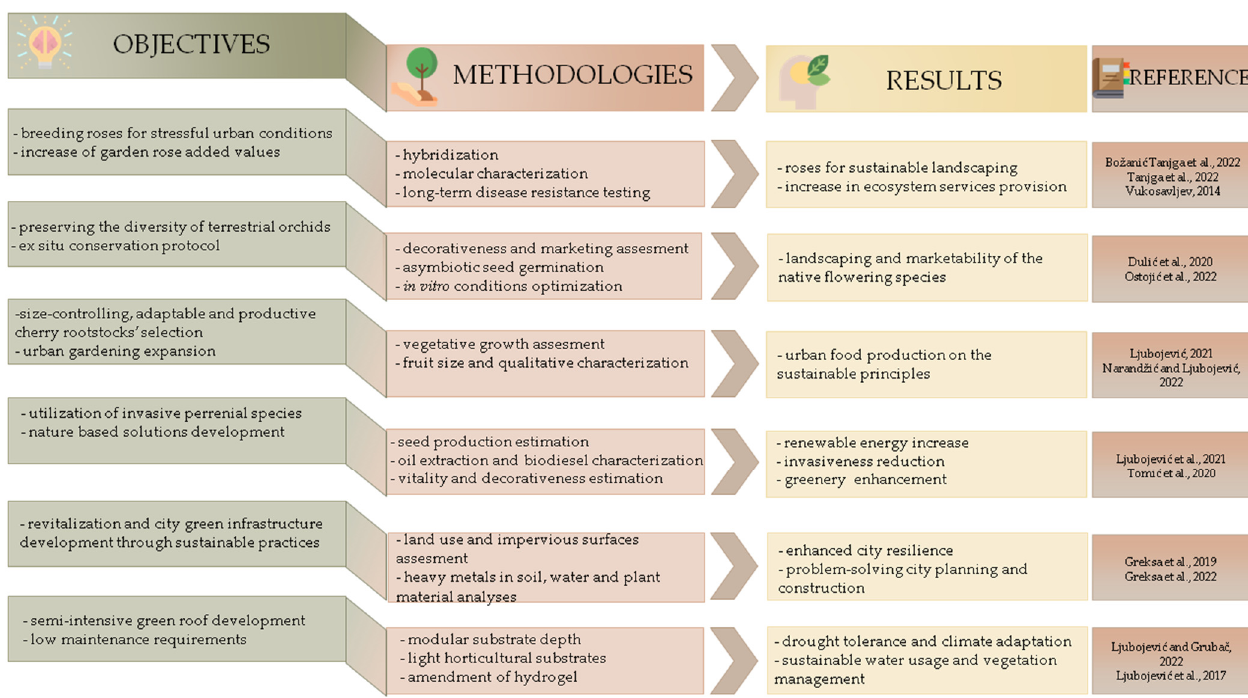
Figure 2. Main objectives, methodologies and results in the selection and breeding of ornamentals, as well as sustainable practices and investigation for sustainable city planning conducted by the research team in the past decade